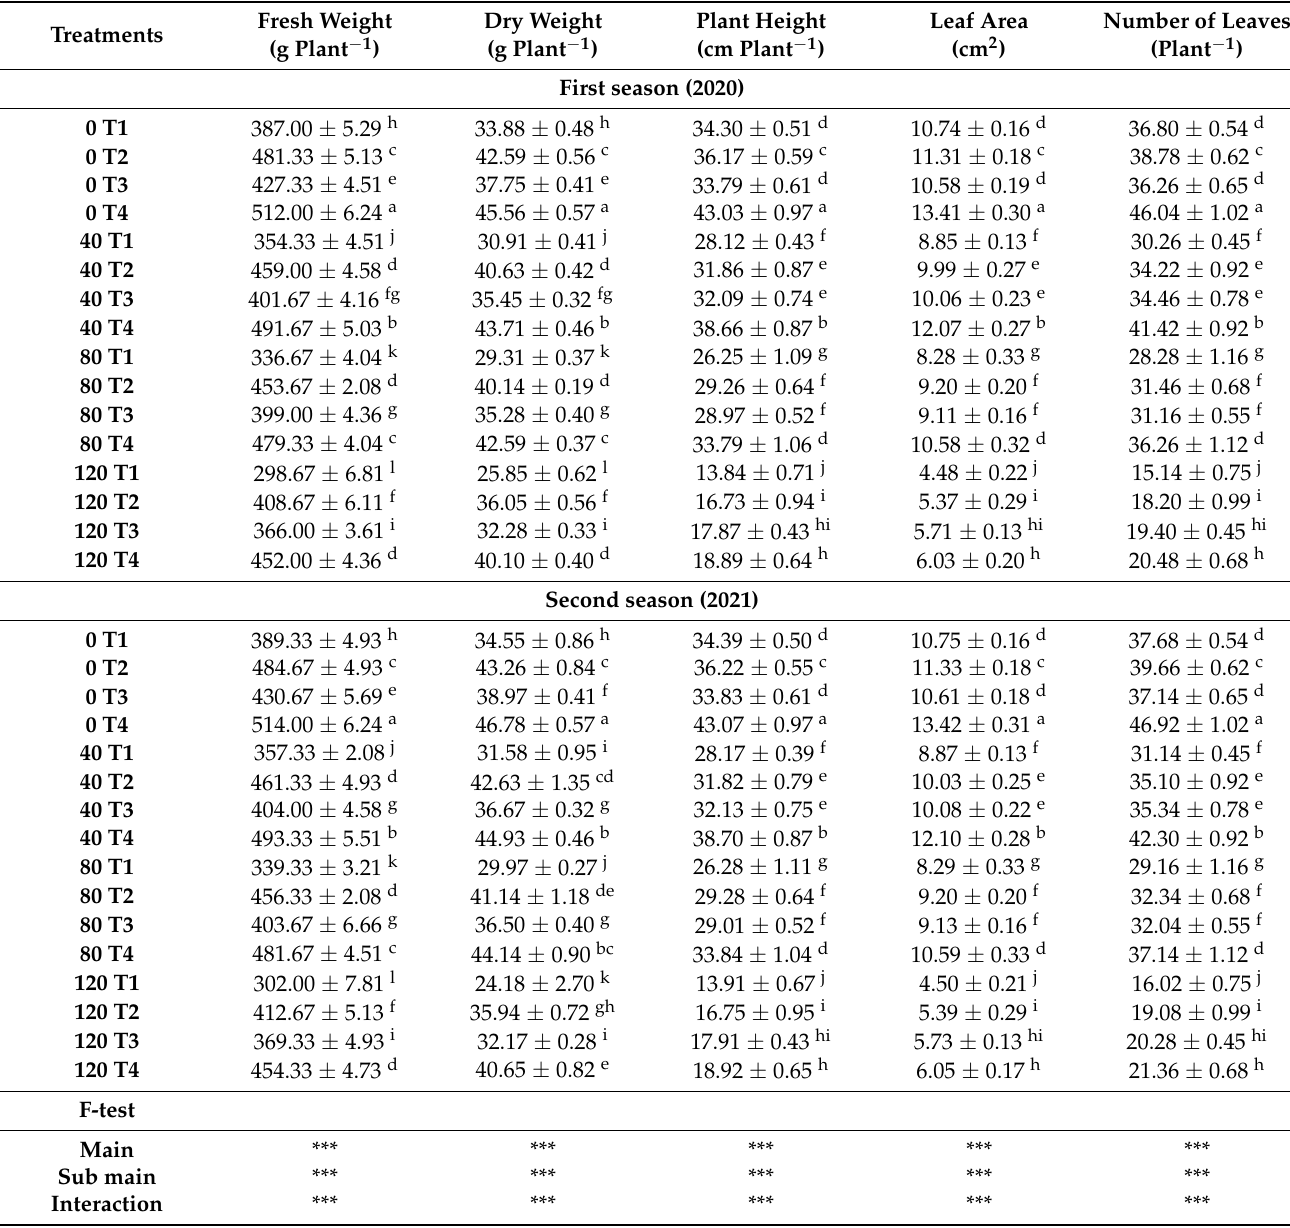
Table 1. Combined effects of different concentrations of Cd and soil amendments on the fresh weight, dry weight, plant height, leaf area, and number of leaves in lettuce plants at 70 days after transplanting during the 2020 and 2021 seasons.